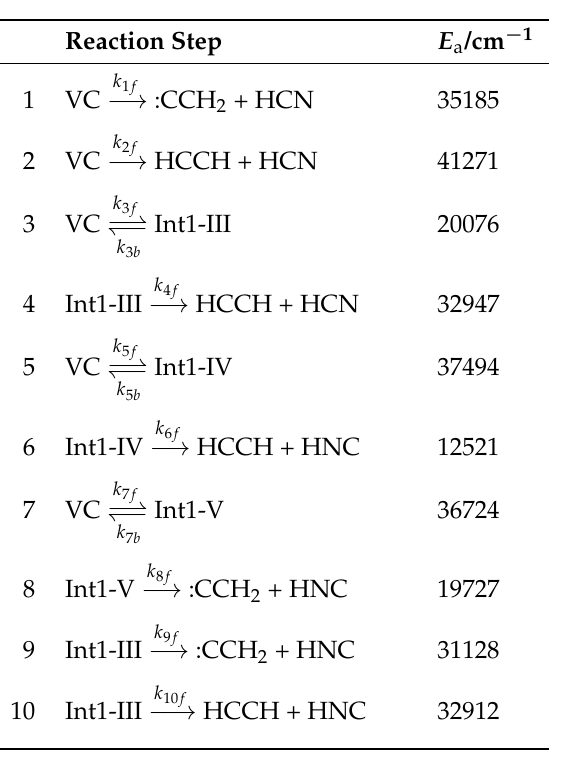
Table 2. Reaction steps involved in the dissociation mechanism of vinyl cyanide considered in this work. The associated activation energies (relative to the zero-point energy of the reactant of each step) are also